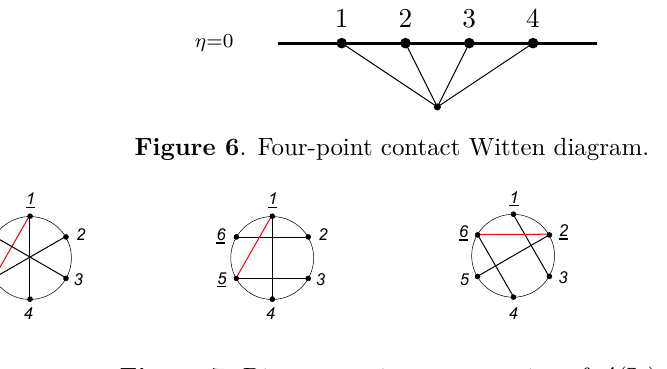
Figure 7 . Diagrammatic representation of A ( I 6 )